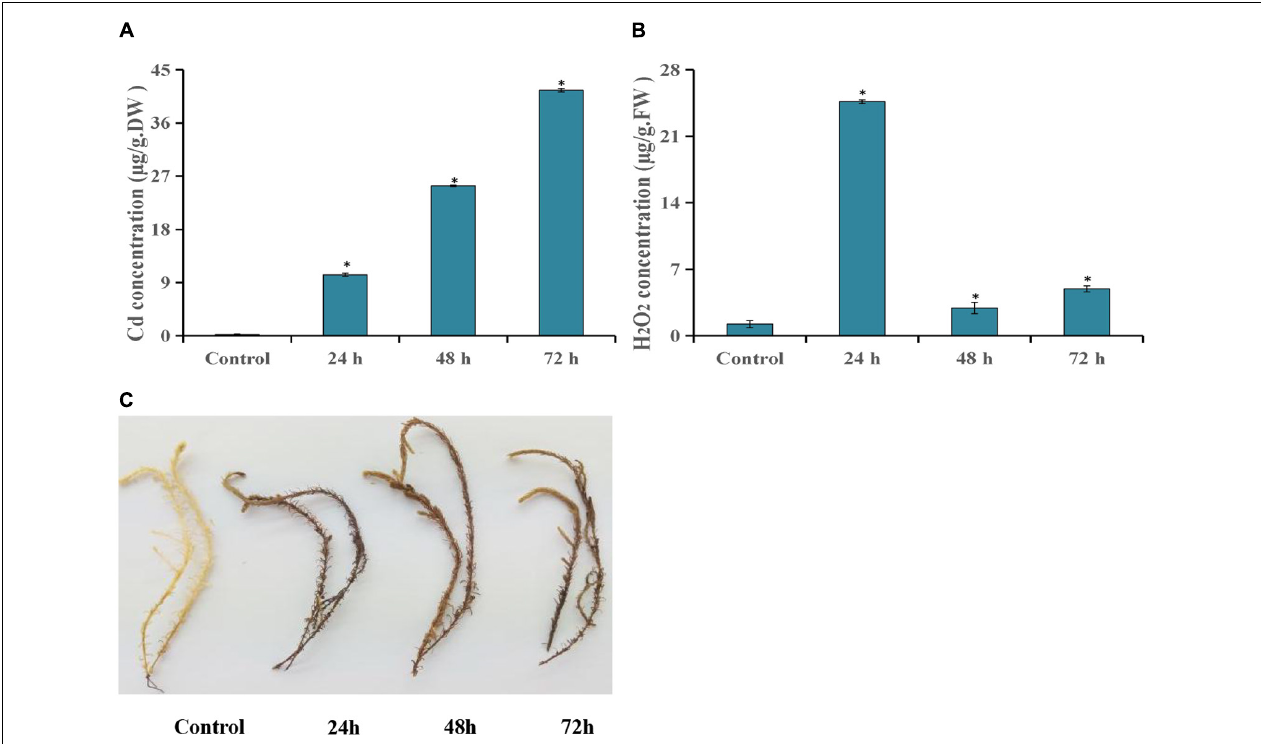
FIGURE 1 | Cd stress analysis of T. hispida. The leaves Cd (A) and H 2 O 2 (B) concentrations in T. hispida at control or under 150 µ mol L - 1 CdCl 2 treated for 24, 48, or 72 h. (C) DAB staining of T. hispida leaves under control or after cadmium stress. * ( P < 0.05) indicate signification difference compared with control.